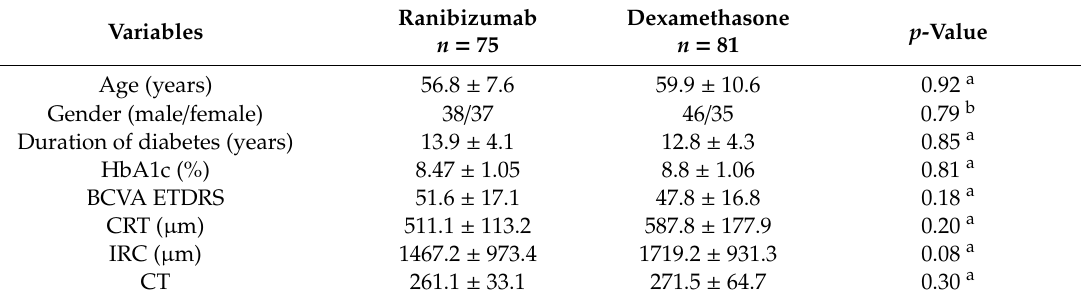
Table 1. Clinical characteristics of the study